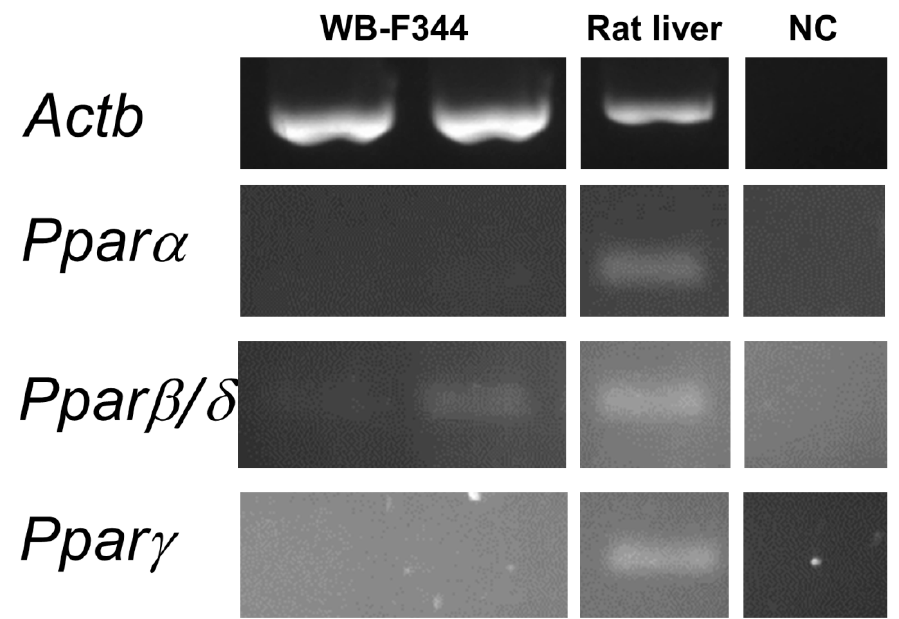
Figure 5. Expression of the Ppar isoforms in rat liver oval WB-F344 cells. RNA was isolated independently from two different cultures of WB-F344. Expression of Ppar α , ß/ δ , and γ was determined by RT–PCR. The reference gene β -actin ( Actb ) was used as a loading control. A sample of RNA extracted from rat liver tissue was used as a positive control to confirm the successful amplification of all Ppar isoforms by RT-PCR. Negative control (NC) sample was negative for all isoforms.